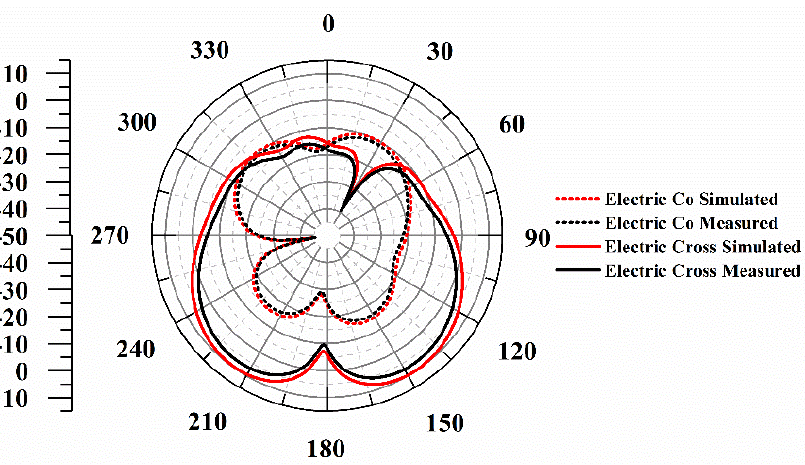
Figure 12. Simulated and measured electric co-polarized and electric cross-polarized fields.